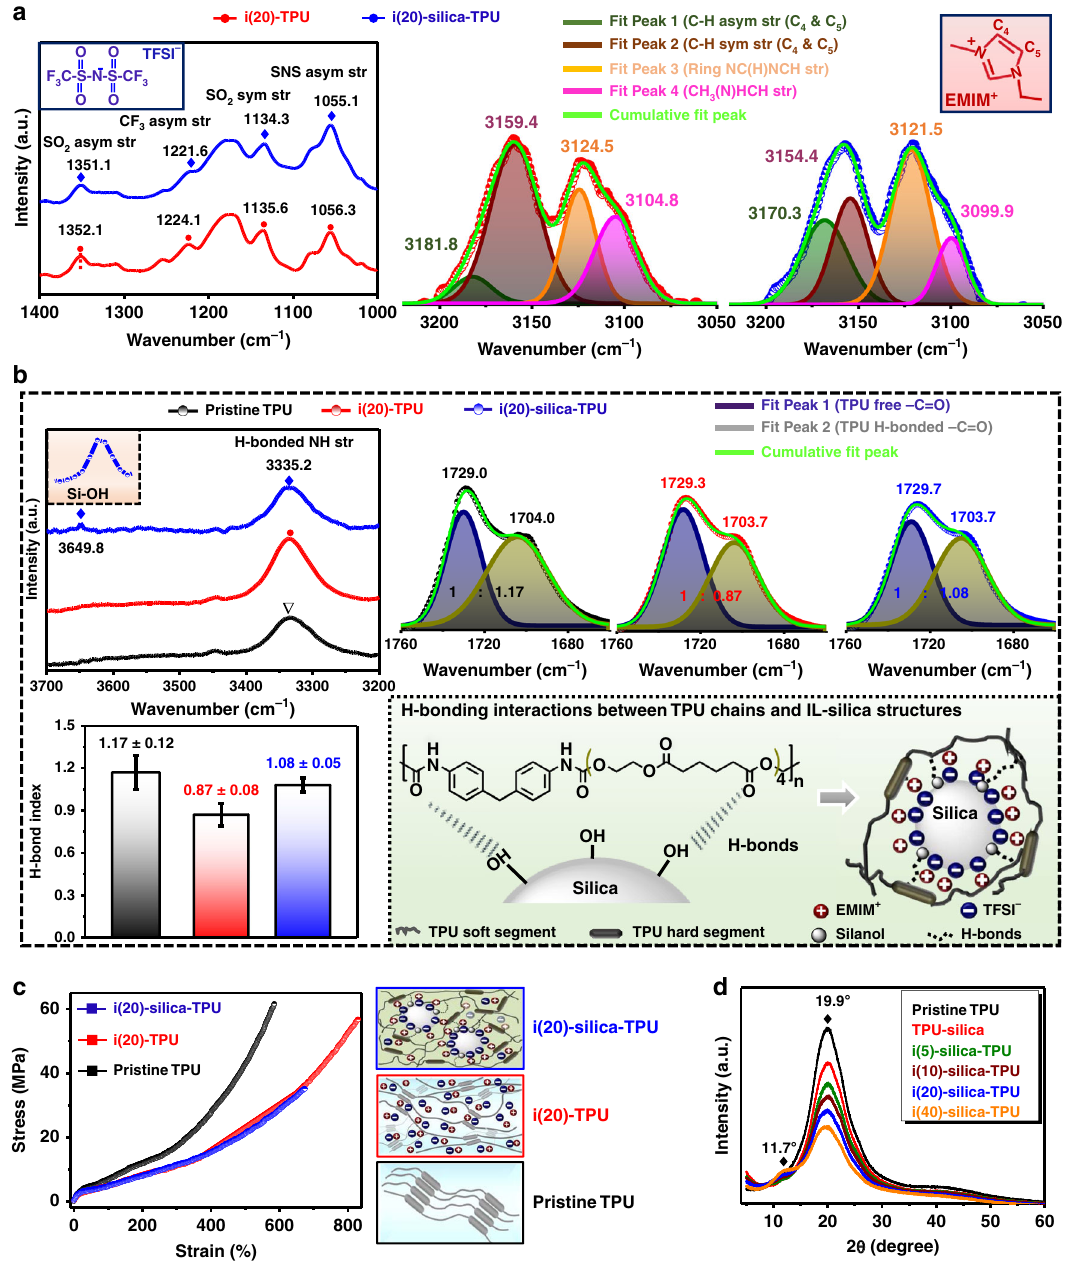
Fig. 4 Double H-bond networks in SMHIP. a ATR – FTIR spectra in the spectral regions 1400 – 1000 cm − 1 (corresponding to TFSI − stretching) and 3200 – 3050 cm − 1 (corresponding to EMIM + stretching); results are shown for i(20) – silica – TPU SMHIP, ristine TPU, and i(20) – TPU. b ATR – FTIR spectra in the spectral regions 3700 – 3200 cm − 1 (N – H stretching of TPU hard segment) and 1760 – 1660 cm − 1 (C = O stretching of TPU). Inset (shown by black dotted box) shows the close-up of Si – OH stretching region observed in i(20) – silica – TPU SMHIP centers at ~3649.8 cm − 1 . Lower inset on the left represents the ca. H-bond index in pristine TPU, i(20) – TPU, and i(20) – silica – TPU SMHIP. Lower inset on the right is the schematic illustration of H- bonding interactions (shown by dotted black lines) between IL – silica (arti fi cial cell) and TPU polymer chains (extracellular matrix) in i(20) – silica – TPU SMHIP. Error bars represent standard deviation in n = 5 samples. c Stress – strain curves of pristine TPU, i(20) – TPU, and i(20) – silica – TPU SMHIP; schematic illustrates the structural differences. d XRD patterns of IL – silica – TPU SMHIP fi lms with varied amount of ILs (5 – 40 wt%). Source data for d are provided as a Source data fi le